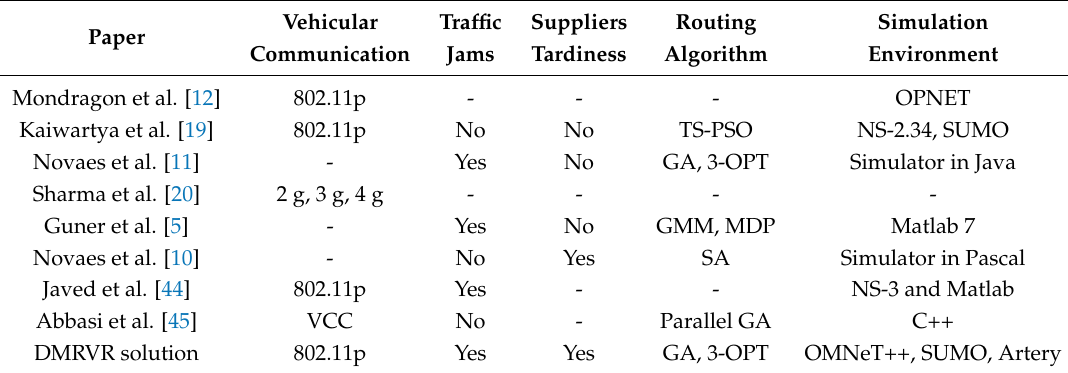
Table 1. Comparative of related works with the DMRVR